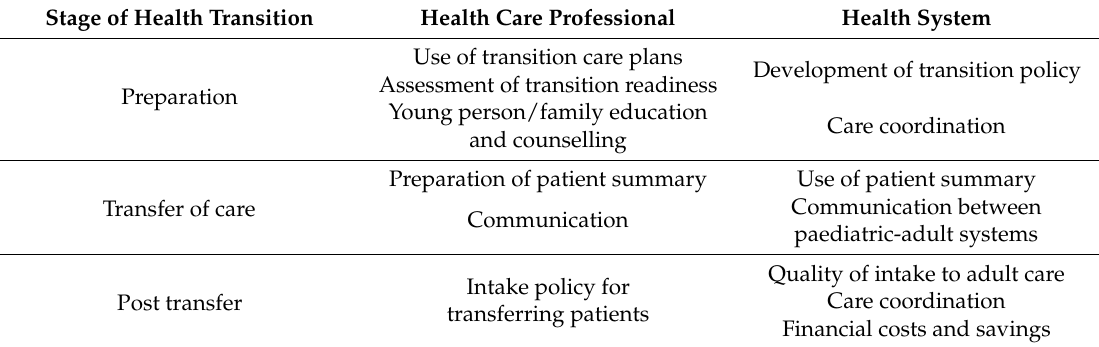
Table 5. Sharma et al.’s [29] outcome indicators for the role of the team and organisation in health